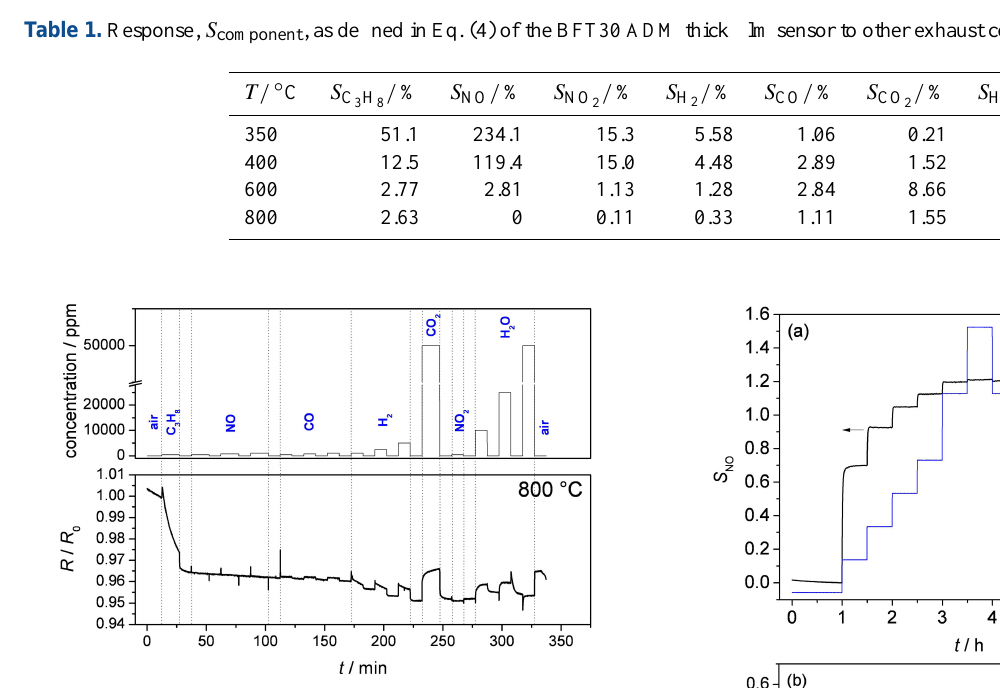
Figure 6. Cross-sensitivity result of a BFT30 ADM-coated sensor at 800 ◦ C (base gas is synthetic air).